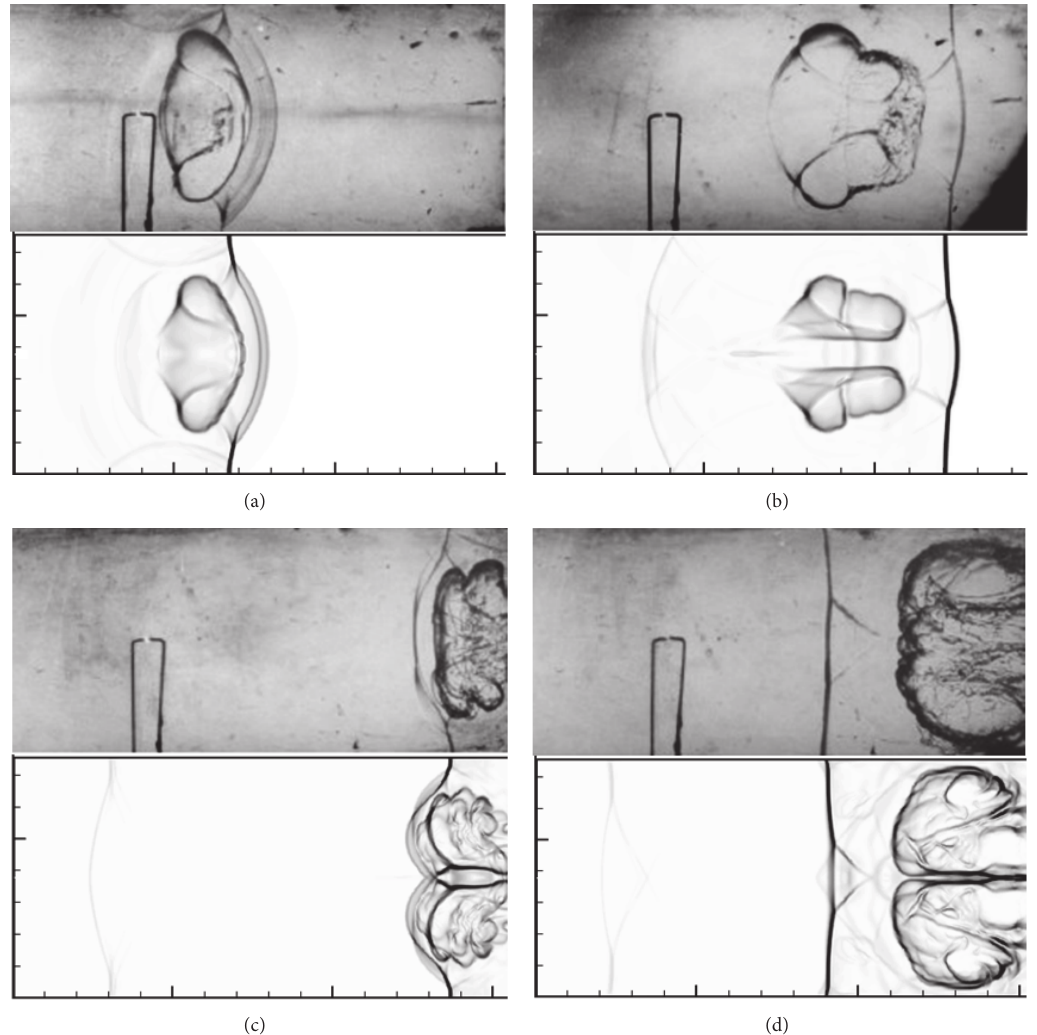
Figure 3: Comparisons between experimental (top) [20] and computational (bottom) Schlieren images: (a) 𝑡 = 99 𝜇 s; (b) 𝑡 = 189 𝜇 s; (c) 𝑡 = 382 𝜇 s; (d) 𝑡 = 501 𝜇 s.